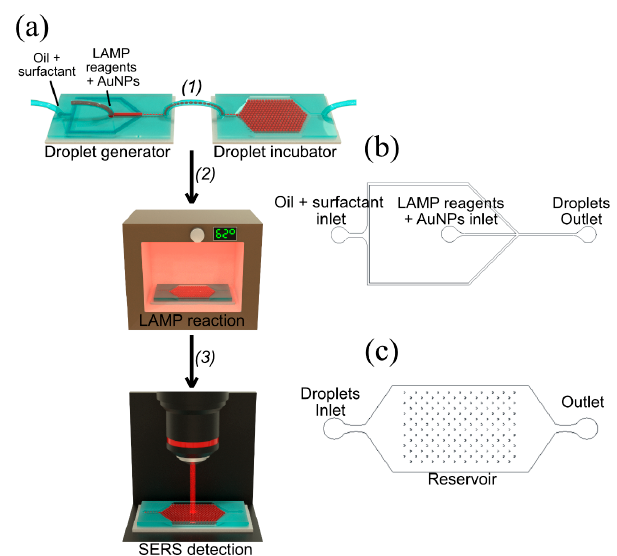
Figure 4. ( a ) Schematic illustration of the experimental setup for microdroplet array-based SERS LAMP analysis: (1) Microdroplet generator device; (2) Microdroplets stored into trapping array were incubated at 62 °C for 60 min to produce the DNA amplification by LAMP and (3) SERS signal emerging from positive droplets was detected on the microdroplets contained in the reservoir using a confocal Raman microscope; ( b ) AutoCAD design for the microdroplets generator and ( c ) AutoCAD design of the microdroplet incubator. The size of microdroplets generated was ≈ 100 µ